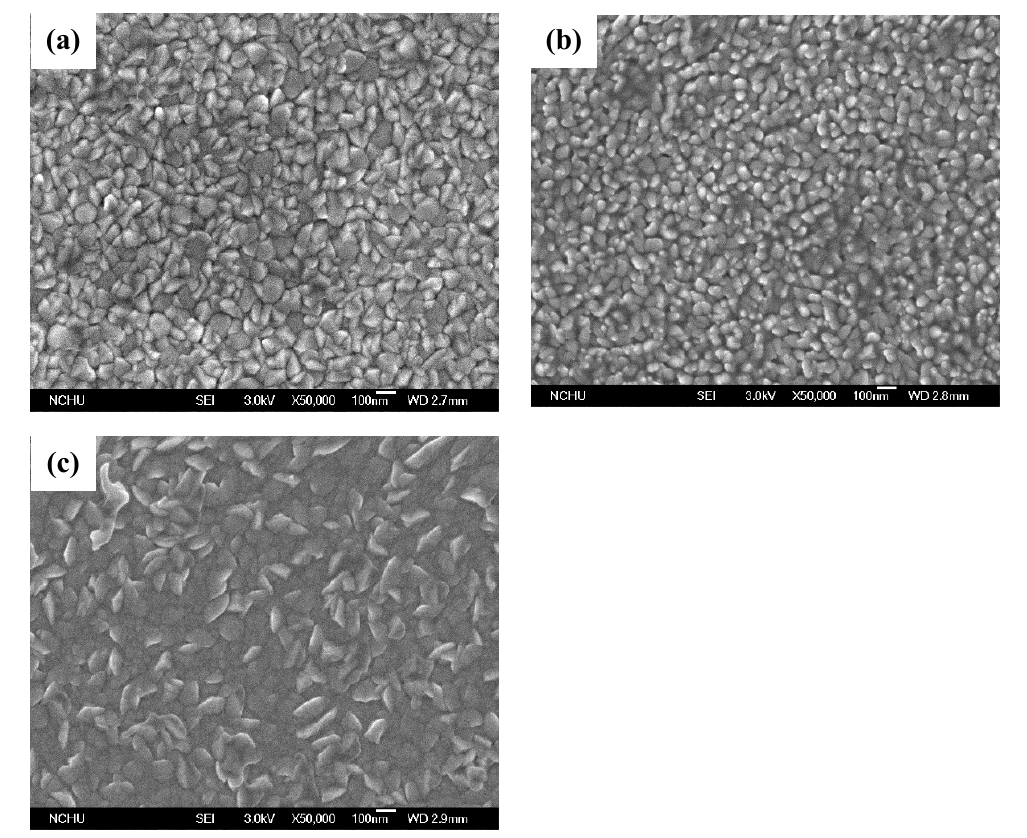
Figure 5. Surface morphologies of the ( a ) undoped ZnO films and cosputtered AlN-ZnO films with Al atomic ratios of ( b ) 20% and ( c ) 40%, respectively, after annealing at 700 °C under vacuum ambient for 30 min from the FE-SEM measurements.